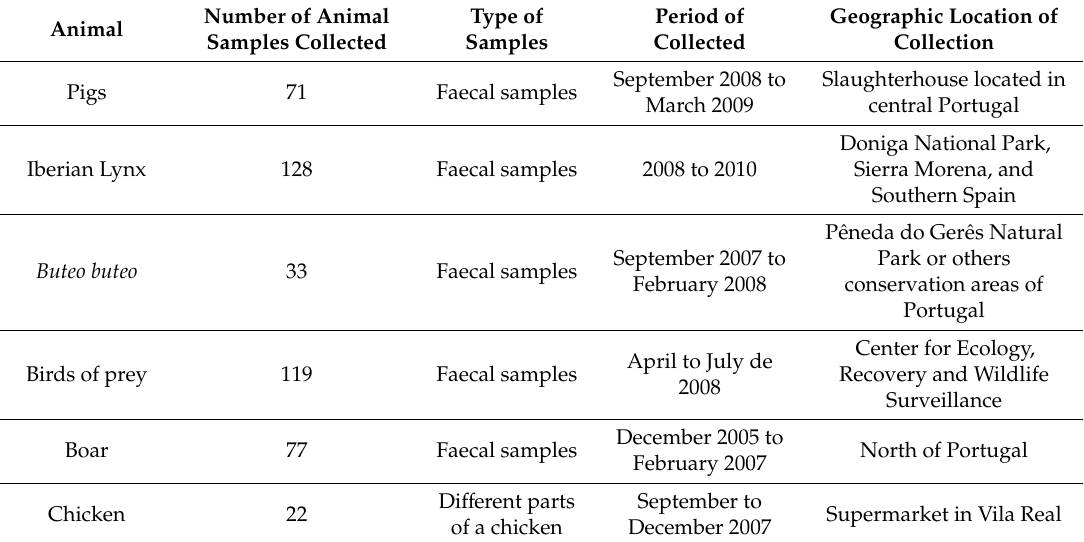
Table 1. Data on the origins of the E. coli strains used in this